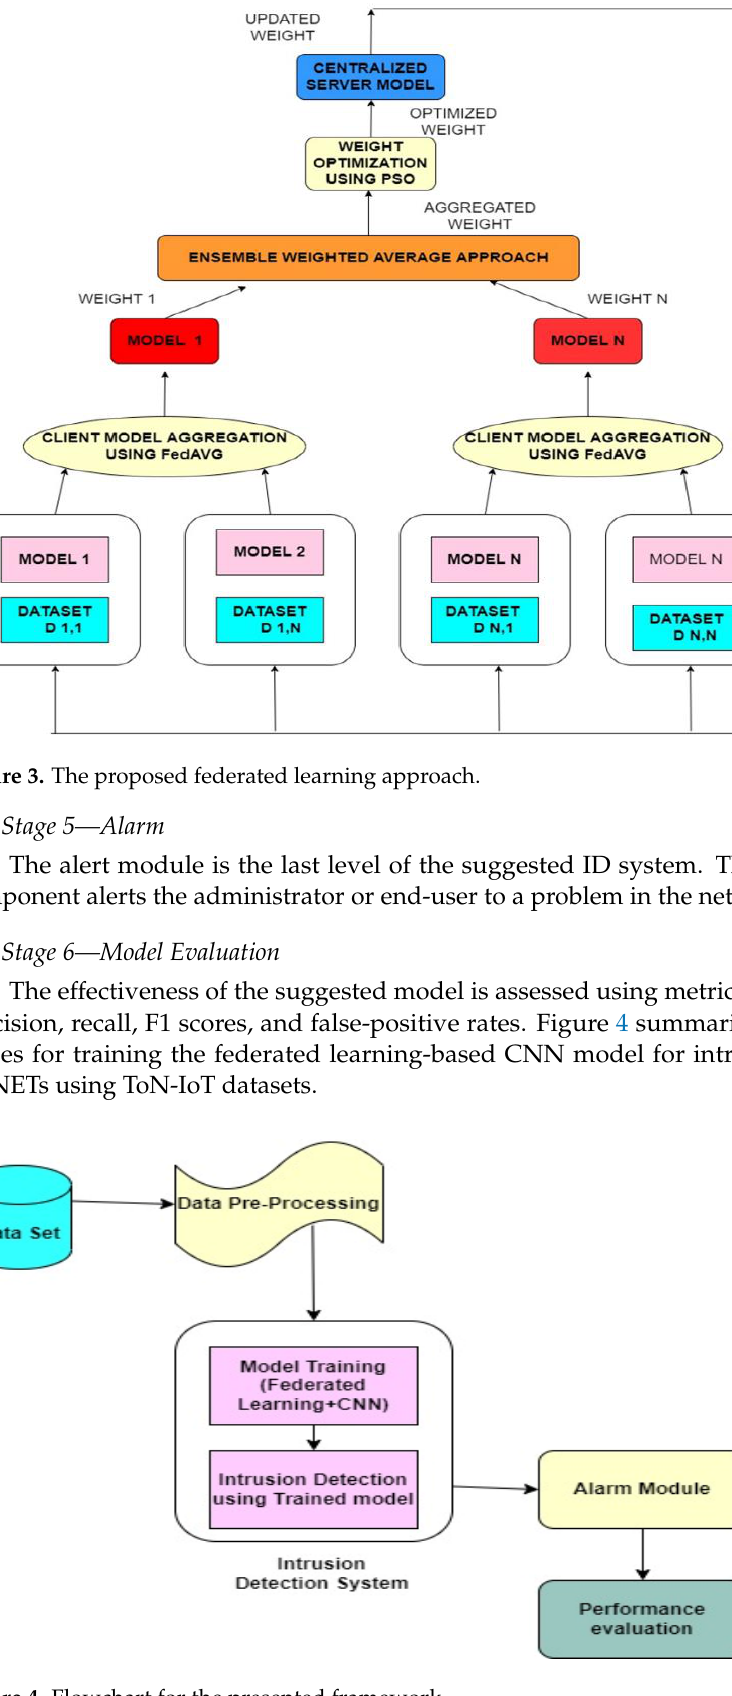
Figure 4. Flowchart for the presented framework.